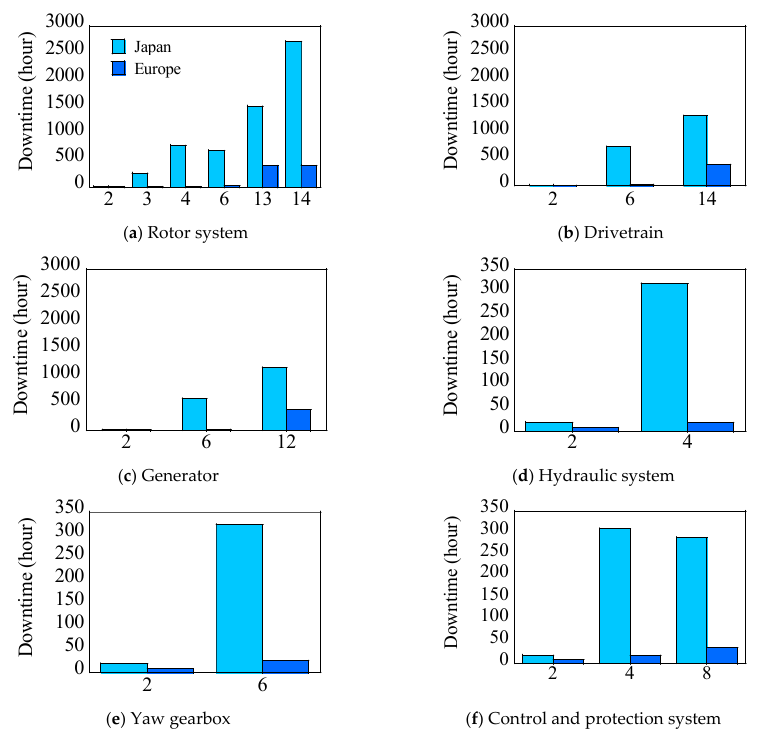
Figure 4. Comparison of downtime between NEDO and Reliawind databases.